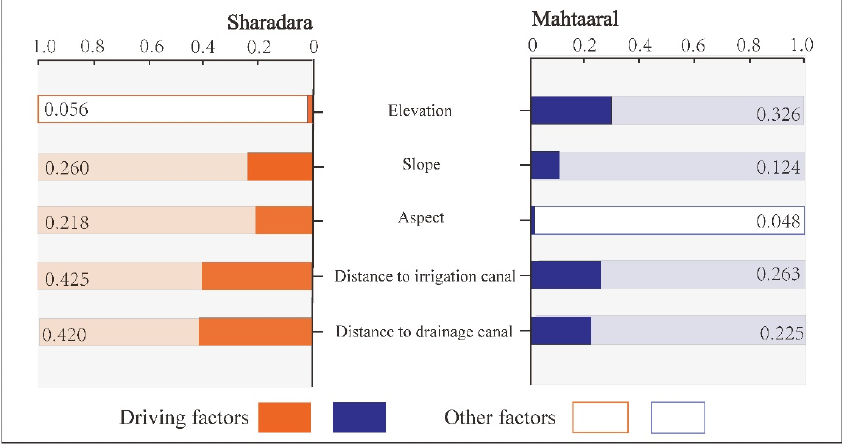
Figure 9. The explanatory power of different influencing factors on soil salinity in Shardara and Mahtaaral